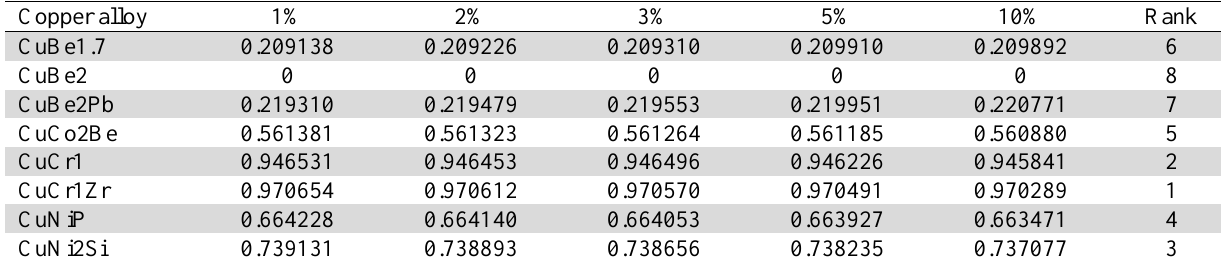
Effect of change in greyness on ranking of copper alloys Copper